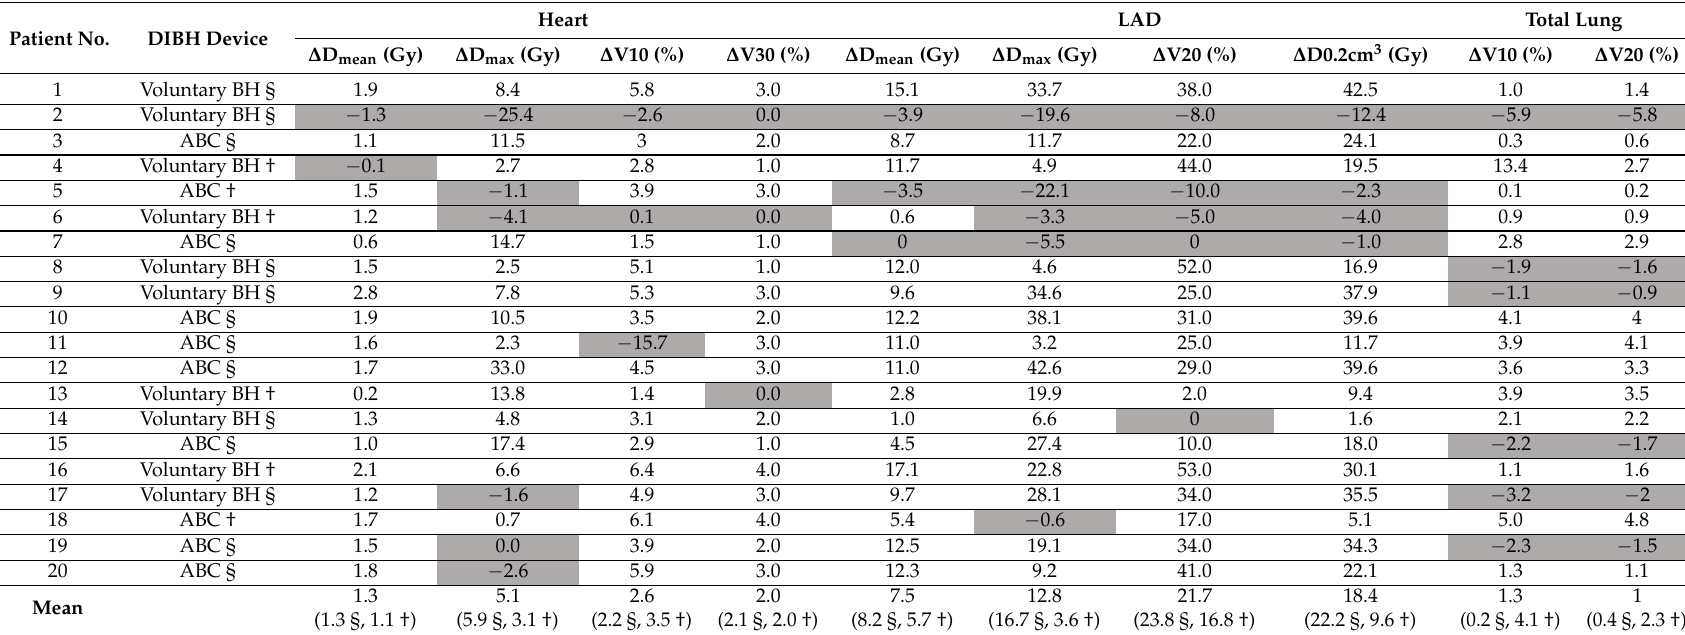
Table 4. Dosimetric differences ( ∆ ) from CT FB - CT DIBH plans for OAR for all 20 patients. Patient